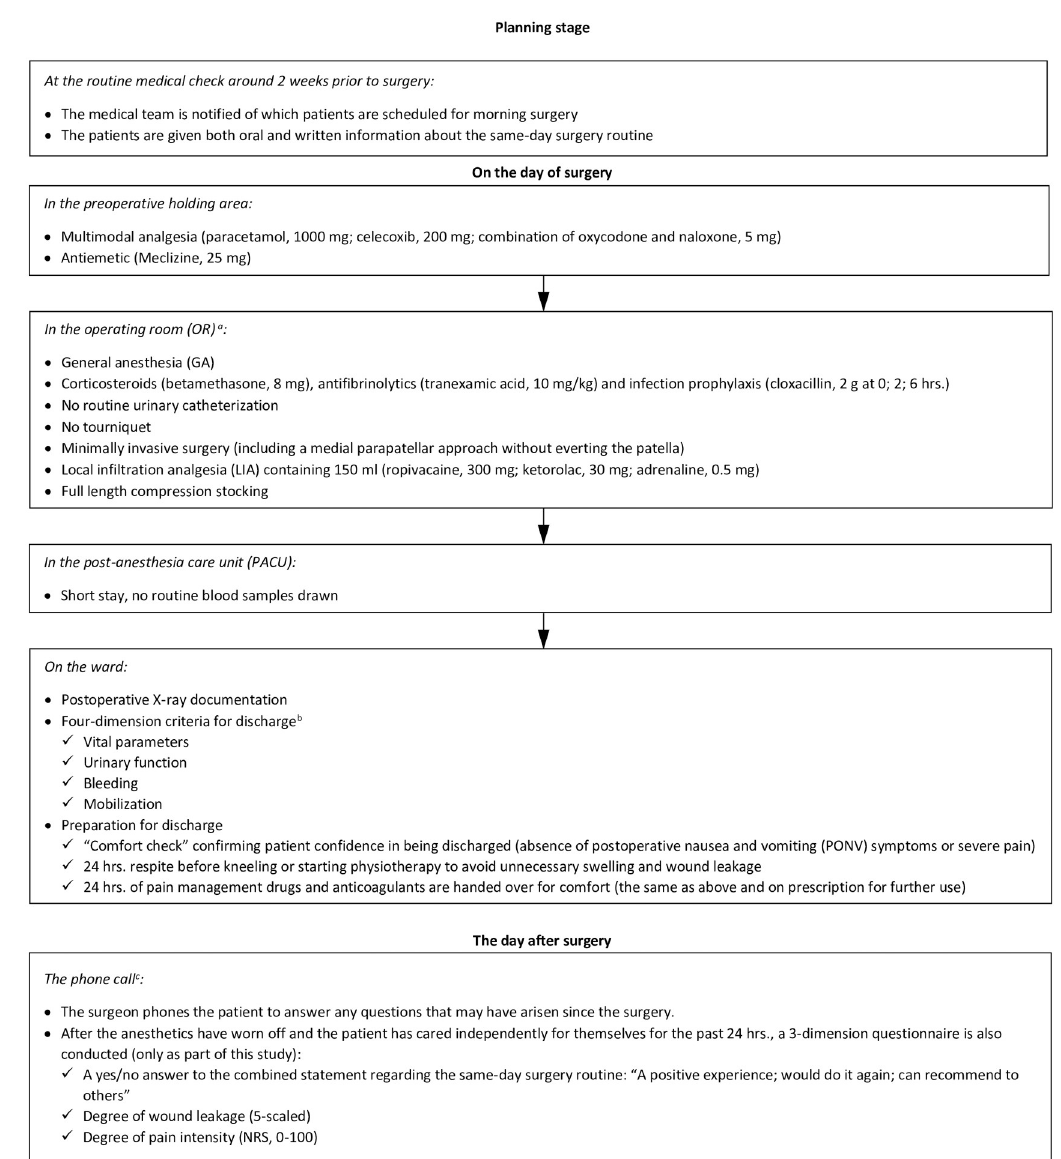
Fig 3. The algorithm for the same-day surgery protocol. a The perioperative regime aimed at optimizing for rapid mobilization and avoiding early postoperative numbness (GA), urinary retention (no catheter), bleeding (antifibrinolytics and compression stockings), stress (corticosteroids), and discomfort (LIA and logistics). b As no preselection of patients was made, it was all the more important to have strict criteria for discharge: Vital parameters were measured and scored by the National Early Warning Score (NEWS), where the threshold was set to NEWS 0. As for the urinary function, less than 200 ml of residual volume after spontaneous void was required. No wound leakage was allowed, and a physiotherapist made sure that the patient could perform ADL safely before discharge could be considered. c It was anticipated that not all information would be comprehended right after surgery and questions might arise, which is why the protocol emphasizes that the surgeon must always call the day after surgery to answer any questions and to evaluate any early signs of